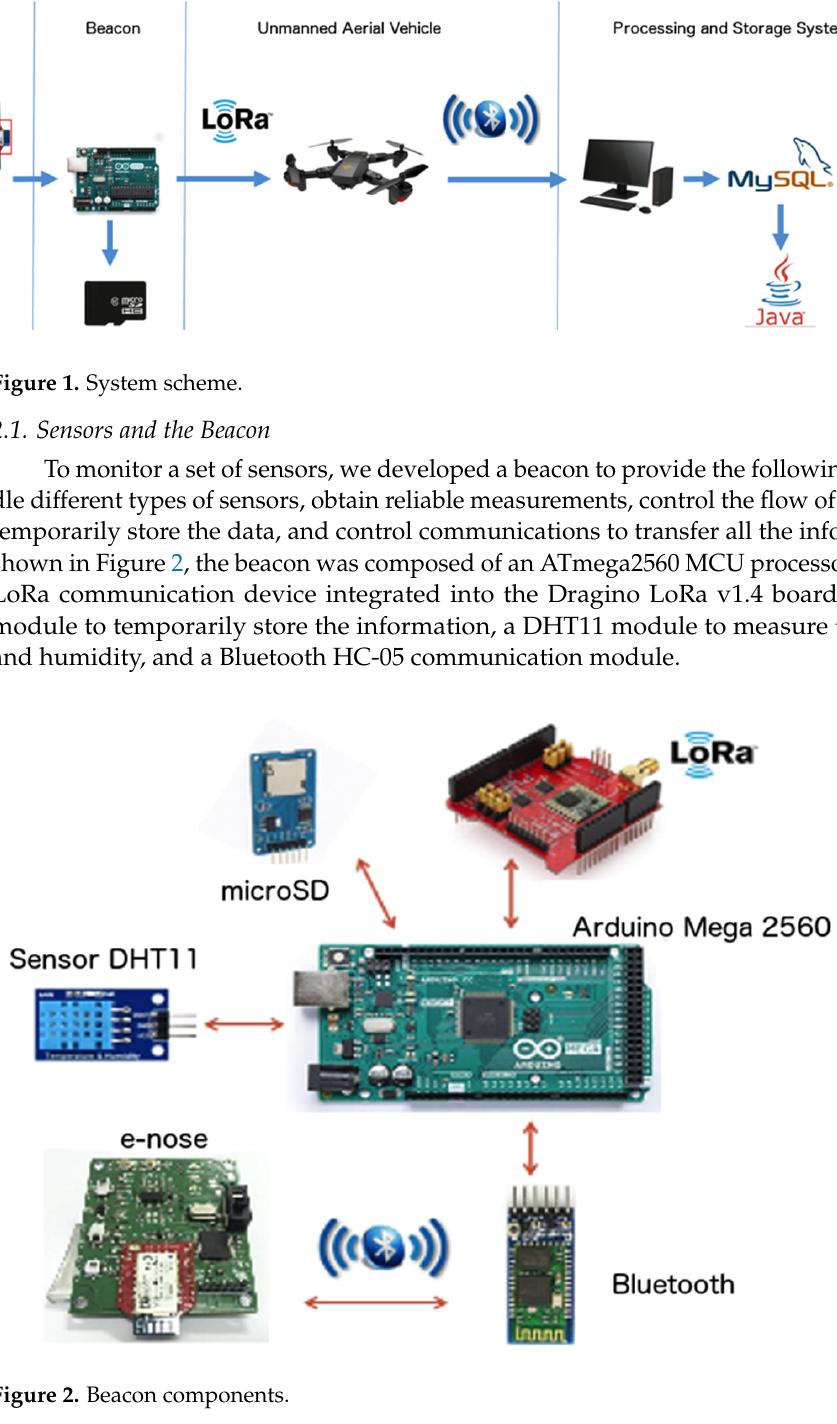
Figure 1. System scheme.